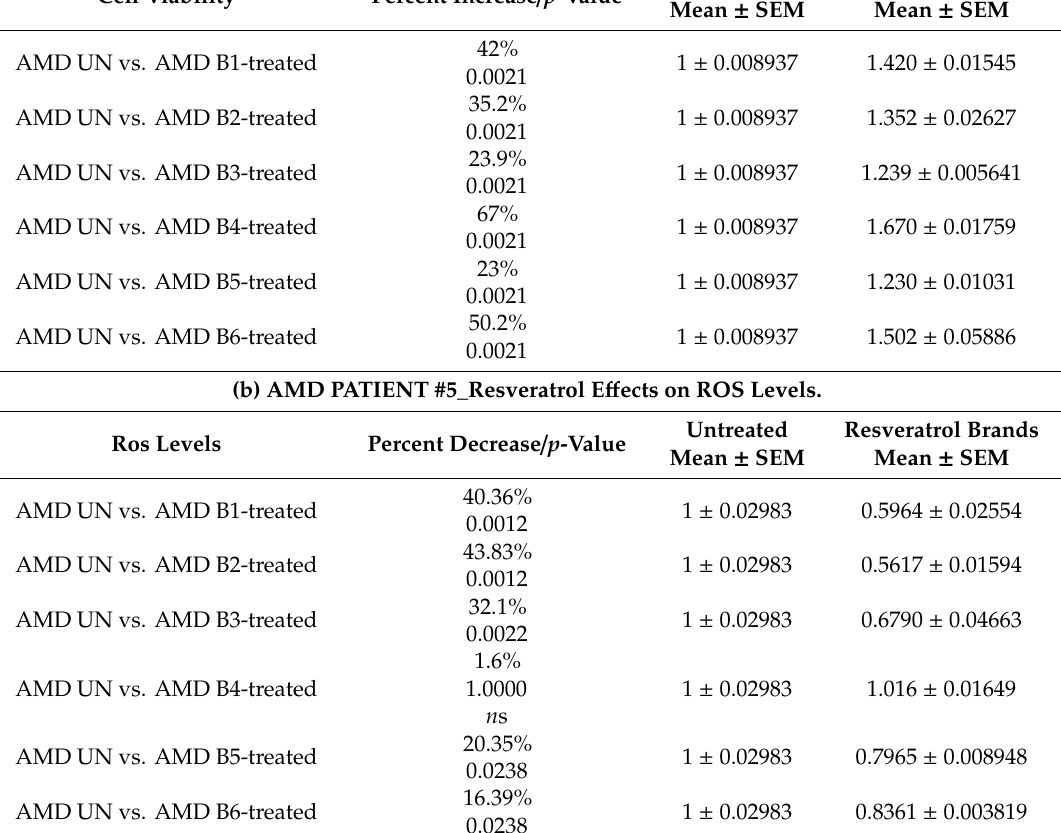
Table 7. E ff ects of resveratrol formulations on cell viability ( a ) and ROS levels ( b ) in AMD patient # 5. (a) AMD PATIENT #5_Resveratrol E ff ects on Cell